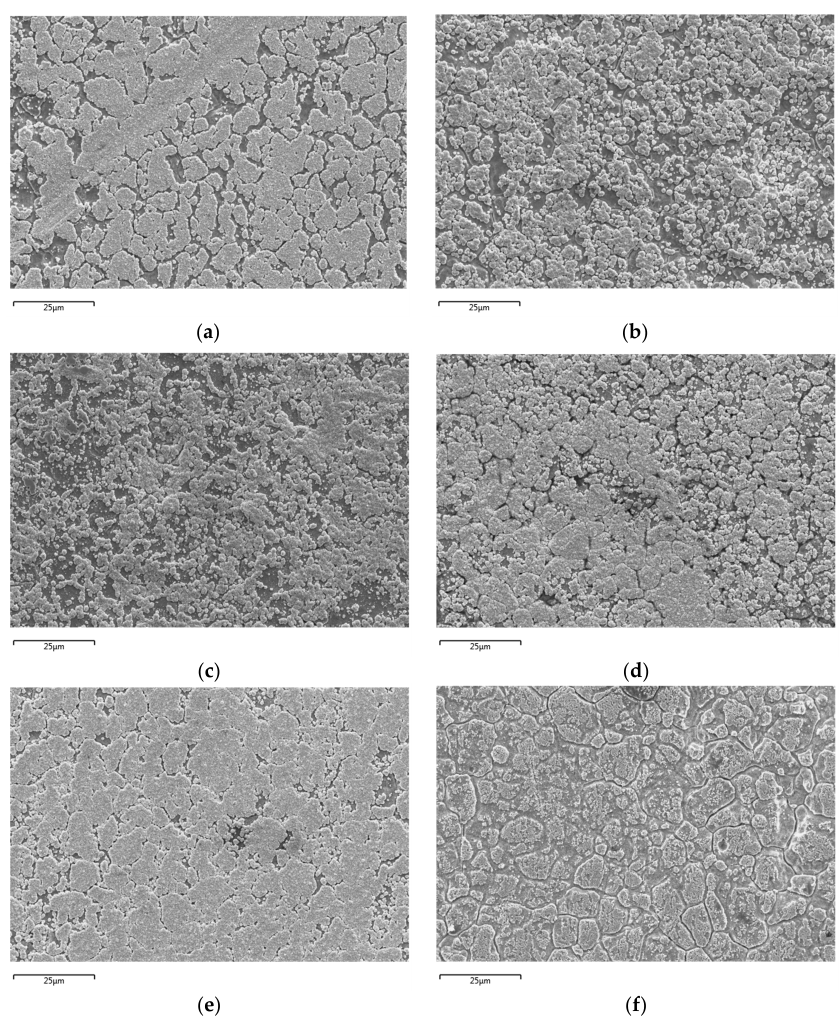
Figure 2. SEM micrographs at ×1000 magnification. ( a ) Direct current plating (DCP) with FC ‐ 4:PTFE